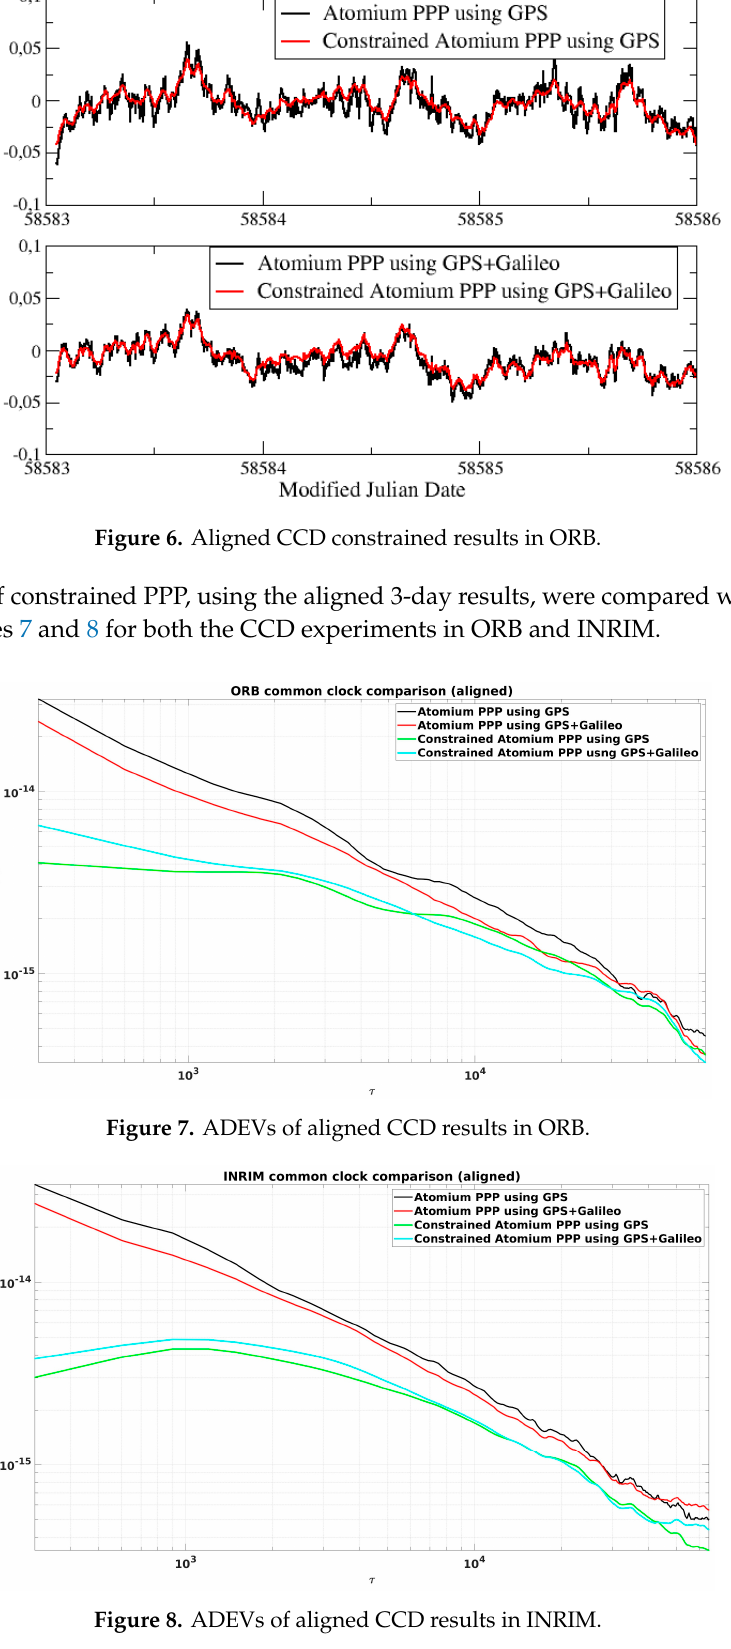
Figure 5. CCD constrained results in ORB.